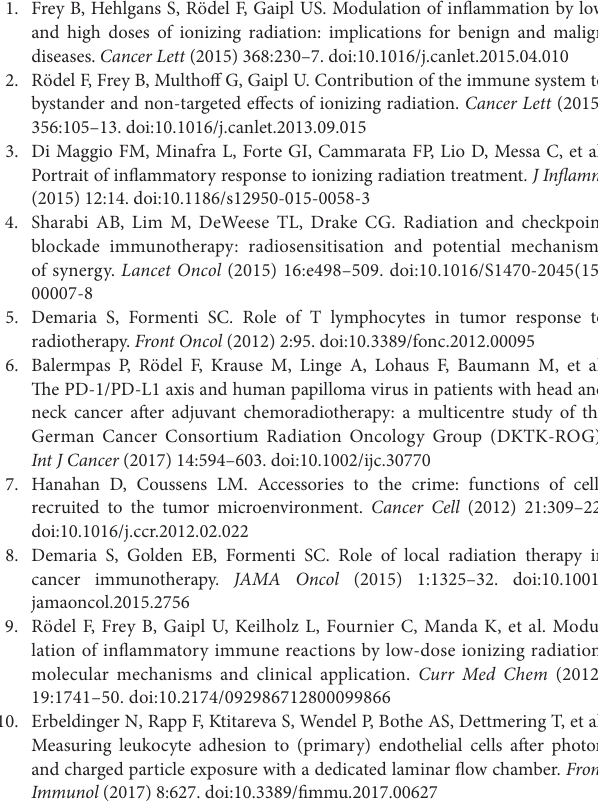
FigUre s1 | Ionizing irradiation stimulates adhesion of peripheral blood lymphocytes (PBL). Relative adhesion rates of PBL to endothelial cells. Cells were incubated at 4°C (open circles) or 37°C (closed circles) without ( − ) or with ( + ) TNF- α (20 ng/ml). Cell were further treated with CD3/CD28/CD2 T-cell activator (25 µl/ml), irradiated with 1.25 Gy X-ray in absence or presence of